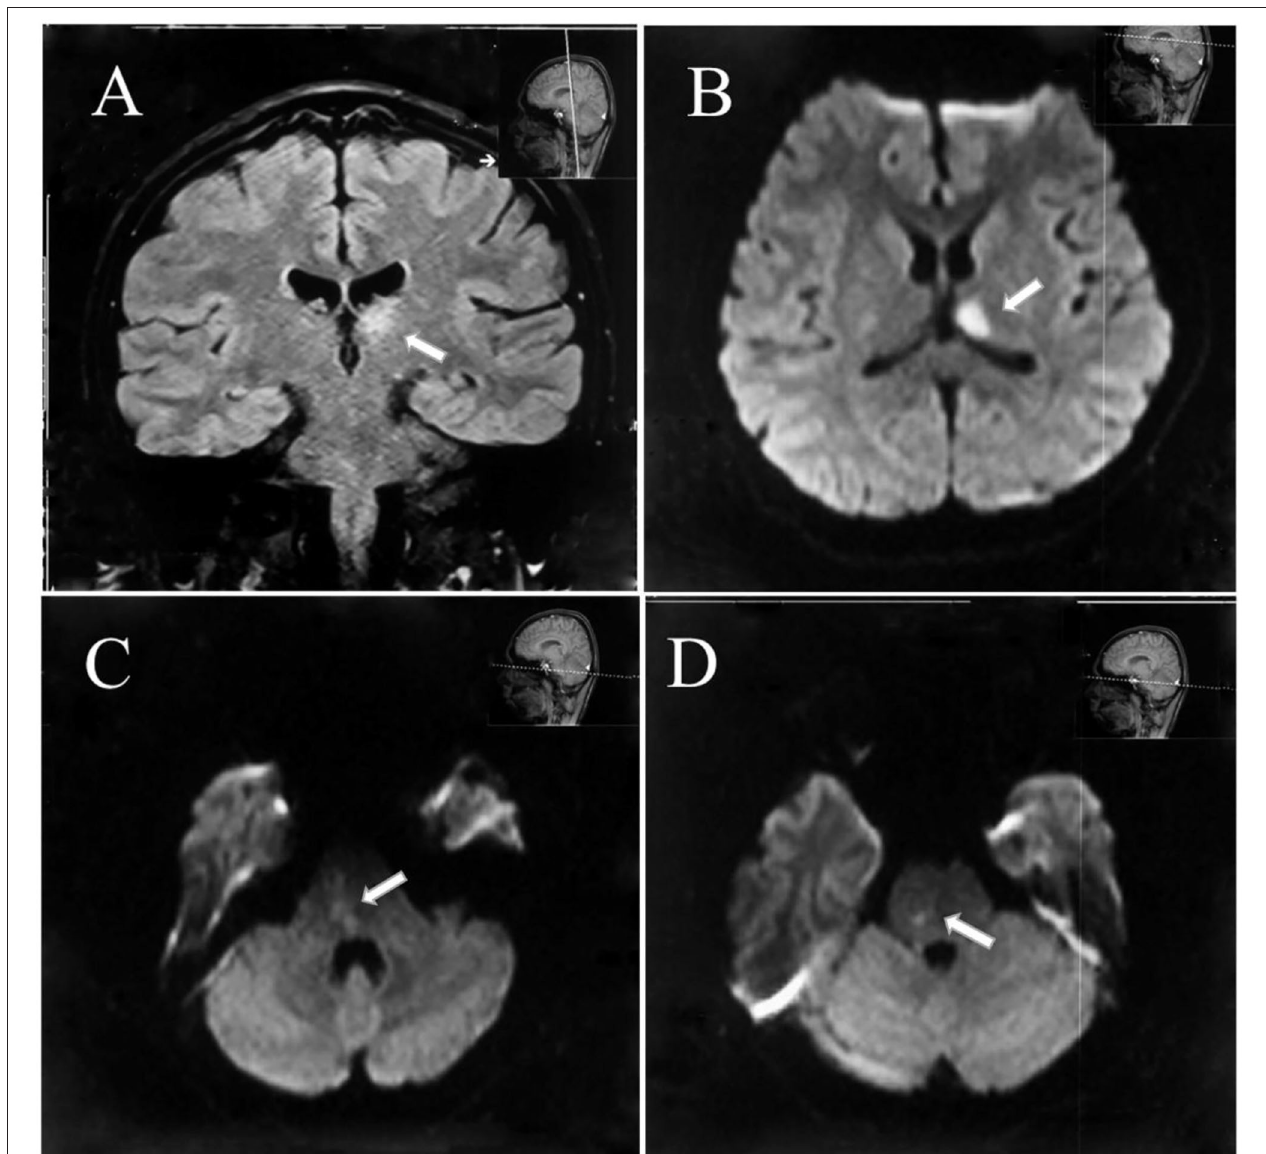
FIGURE 2 | Diffusion restriction of the left thalamus (A,B) and the right brain stem as demonstrated on diffusion-weighted magnetic resonance imaging consistent with acute ischemic infarction (C,D) .